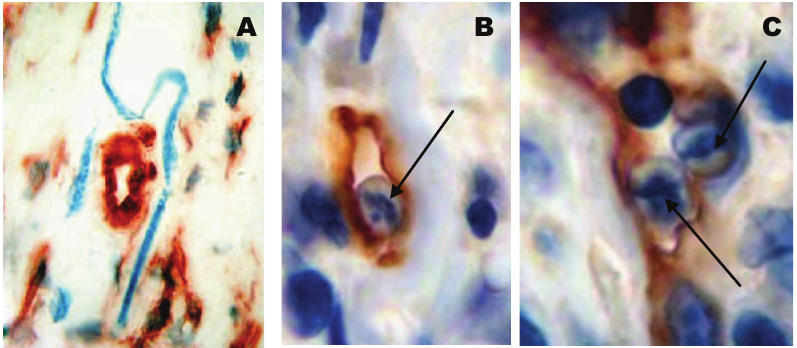
Figure 3. Presence of microfilariae in lymphatic vessels from the nodule. (A) Microfilariae (blue turquoise) in nodule close to a lymphatic section. (B & C) Sections of microfilariae (arrows) within lymphatic vessels in the nodules (Lyve-1 staining). Number of analysed nodules=10. Scales: A, bar=20 m m; B, C, bar=10 m m. doi:10.1371/journal.pone.0008234.g003 PLoS ONE |